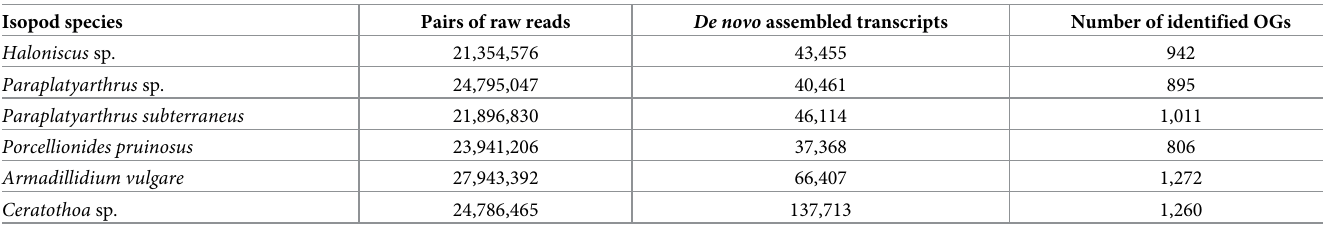
Table 1. Summary statistics for sequencing and de novo assembly of the isopod transcriptomes used in orthology assignment. Isopod species Pairs of raw reads De novo assembled transcripts Number of identified OGs Haloniscus sp. 21,354,576 43,455 942 Paraplatyarthrus sp. 24,795,047 40,461 895 Paraplatyarthrus subterraneus 21,896,830 46,114 1,011 Porcellionides pruinosus 23,941,206 37,368 806 Armadillidium vulgare 27,943,392 66,407 1,272 Ceratothoa sp.